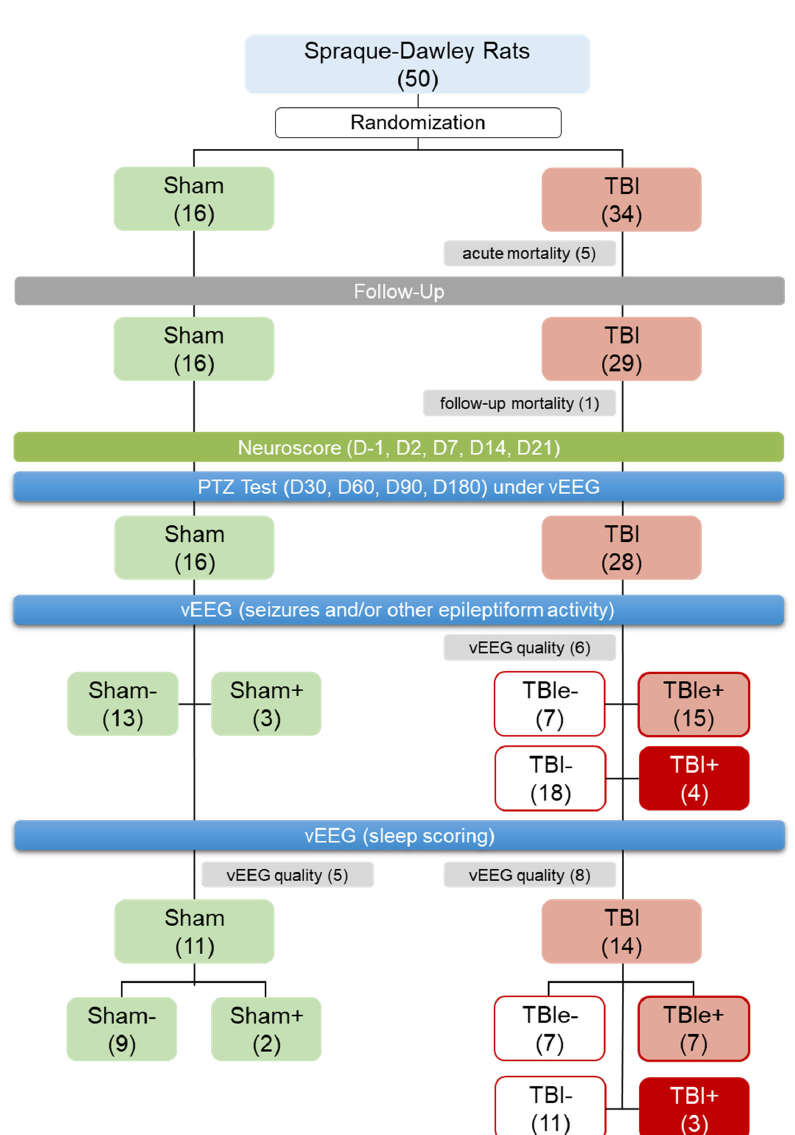
Figure 2. Randomization and study flow: We aimed at having at least 20 rats with traumatic brain injury (TBI) and 10 sham-operated experimental controls to complete the 7-month follow-up. In the TBI group, we expected 25% acute mortality (due to impact) and a 25% follow-up exclusion rate (mostly related to mortality in the pentylenetetrazol (PTZ) test or loss of the electrode headset). In the sham-operated group, we expected 0% acute mortality and a 15% follow-up exclusion rate (due to loss of electrode headset). Altogether, 50 rats were randomized into the sham-operation ( n = 16) or lateral fluid-percussion injury ( n = 34) groups. Acute mortality in the TBI group was 15% (5/34), and follow-up mortality was 3% (1/29). Consequently, 16 sham-operated rats and 28 rats with TBI completed the PTZ testing and 1-month video electroencephalogram (vEEG) monitoring. Of the 28 rats with TBI, 6 had an EEG of insufficient quality, and were excluded from the analysis of epileptiform activity. Of the remaining 22 rats with TBI, 15 showed epileptiform activity in EEG (TBIe+) and 7 did not (TBIe − ). Four of the 22 TBI rats (i.e., 18%) had unprovoked seizures (TBI+, i.e., post-traumatic epilepsy) and 18 did not (TBI − ). Of the 16 rats in the sham group and 28 in the TBI group, 11 (69%) and 14 (50%), respectively, had an EEG of sufficient quality for sleep scoring, and were included in the sleep